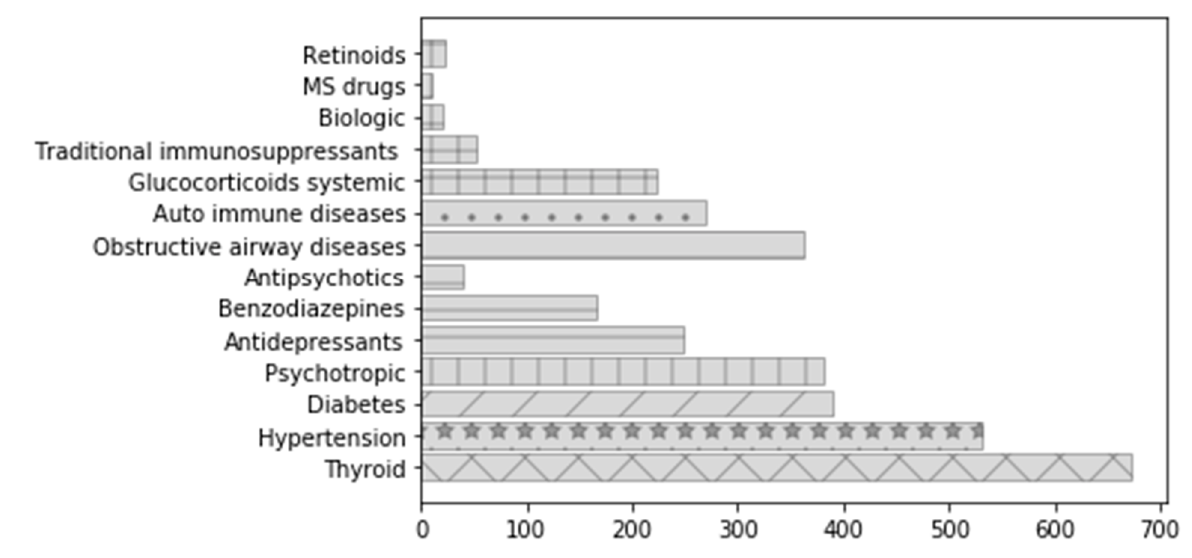
Figure 3. Prevalence of pregnancies per drug group during T1–T3 (Each drug group is shown with a different pattern. The group of psychotropic comprises antidepressants, benzodiazepines and anti-psychotic and is thus represented with the same pattern. The auto-immune disease group comprises glucocorticoids, traditional immunosuppressants, biologic and MS drugs).